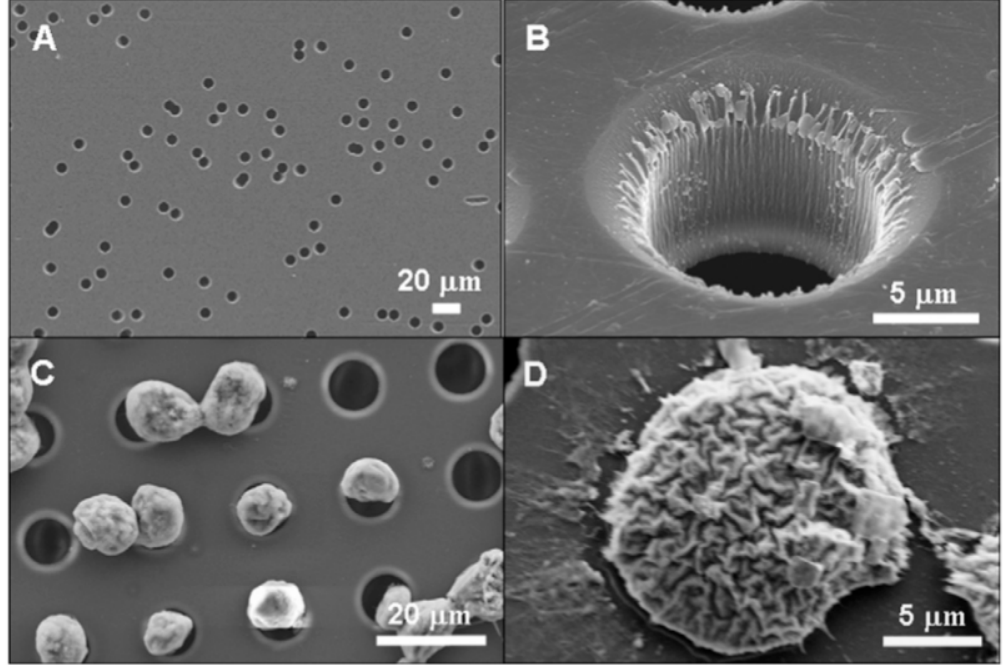
Figure 7. SEM images of ( a ) commercial membrane filter; ( b ) microfabricated parylene membrane filter; ( c ) parylenemembrane filter with cells captured without SEM fixation treatment, and ( d ) parylene membrane filter with cells captured after SEM fixation procedure. Reprinted with permission from [184]. Copyright 2007, Elsevier.